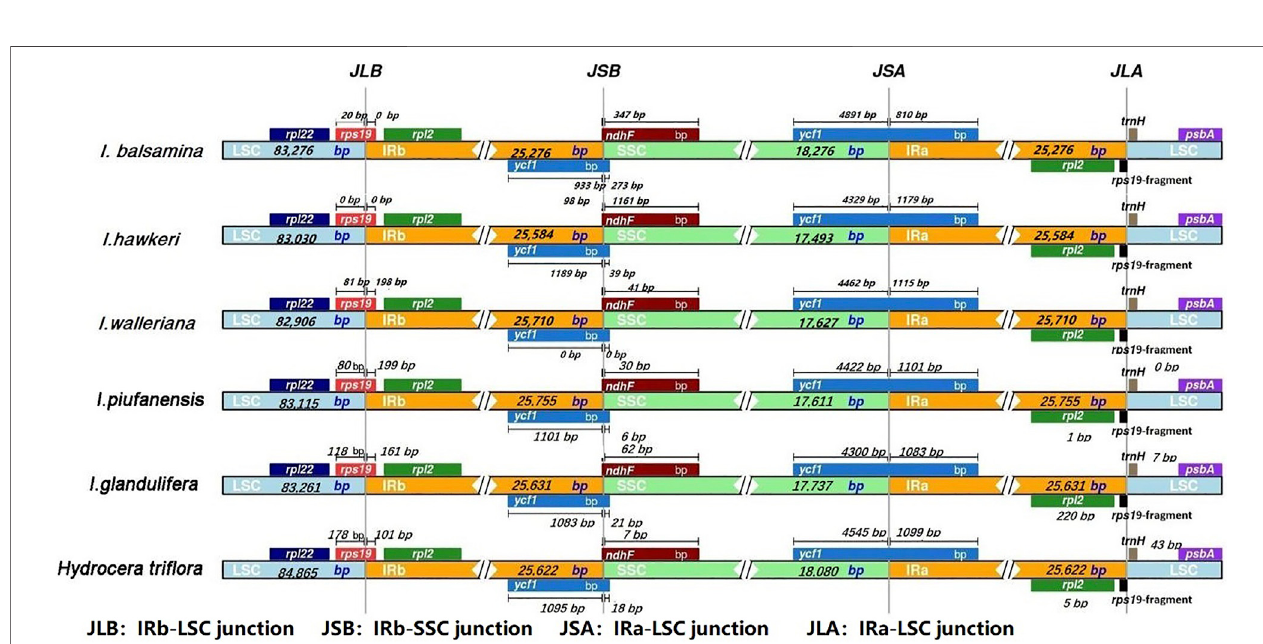
FIGURE 5 | Comparison of the borders of four different regions (LSC, SSC, and IRs) among I. balsamina, I. hawkeri, I. walleriana, I. piufanensis, I. glandulifera, and H. tri fl ora chloroplast genomes.